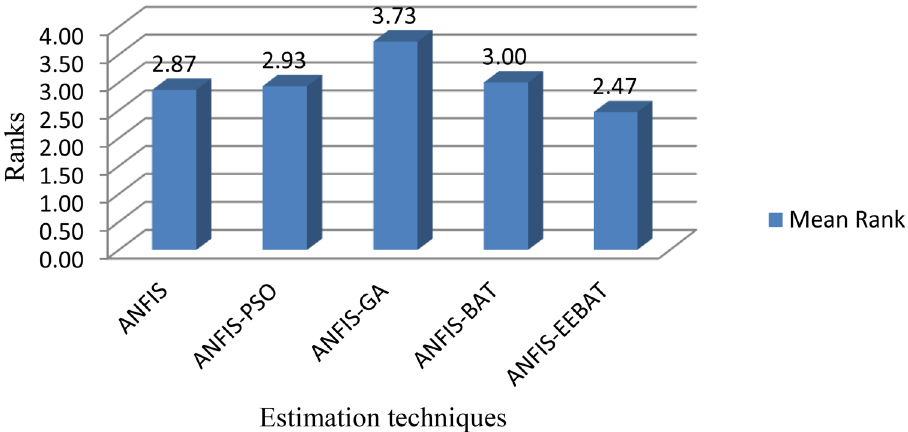
Figure 8. Friedman test rank comparison on ZKmS We have considered our null hypothesis that all the models are similar. The standard chi-square value for 4 degrees of freedom, df, and alpha = 0.05 is 9.488 and our chi-square value is 10.133, which rejects our null hypothesis. The value of Asymp. Sig. (0.038) is less than the significance value of alpha (0.05) which ascertains that models are dissimilar. The mean rank of ANFIS-EEBAT is 2.47 as compared to ANFIS (2.87), ANFIS-PSO (2.93), ANFIS-GA (3.73) and ANFIS-BAT